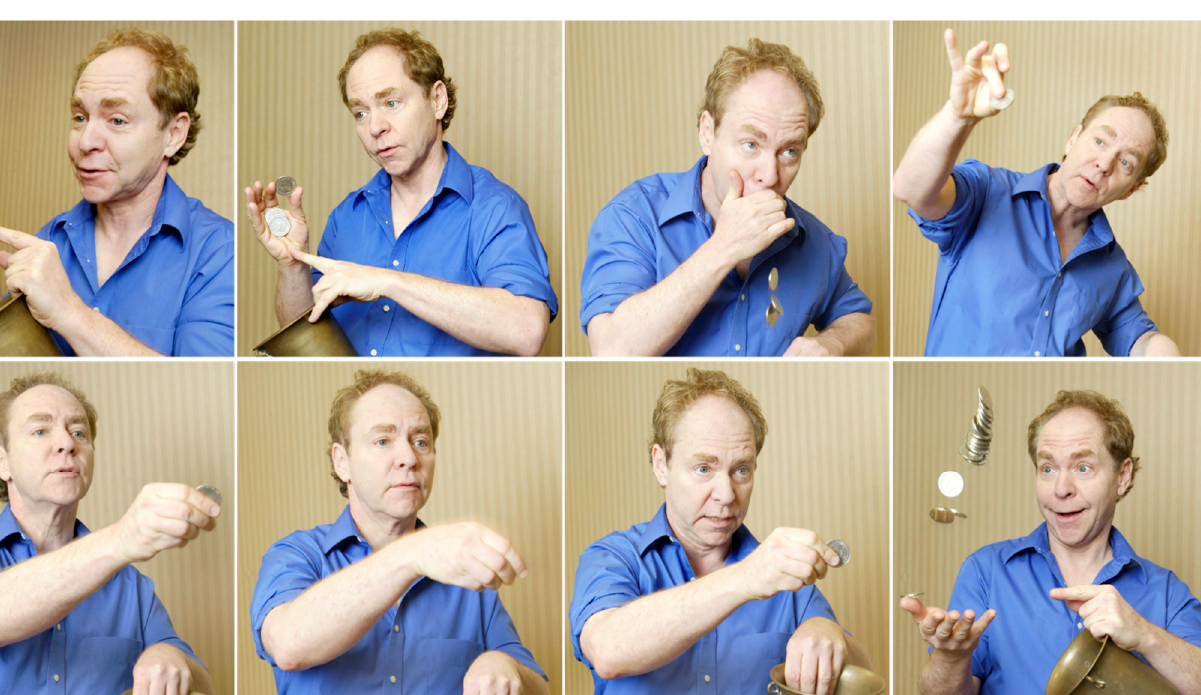
Figure 2. Magician Teller’s performance of The Miser’s Dream trick at the 2007 “Magic of Conscious- ness” Symposium [37]. The Miser’s Dream is a classic magic routine in which myriad coins seem to appear where previously there were none. The magician uses auditory cues with precise timing to make audiences believe that many coins have dropped into the metal bucket when that was not the case. Teller relies on the audience’s multi-sensory integration processes, using his body language, gaze direction, and sleight of hand techniques to misdirect spectators. From [16].